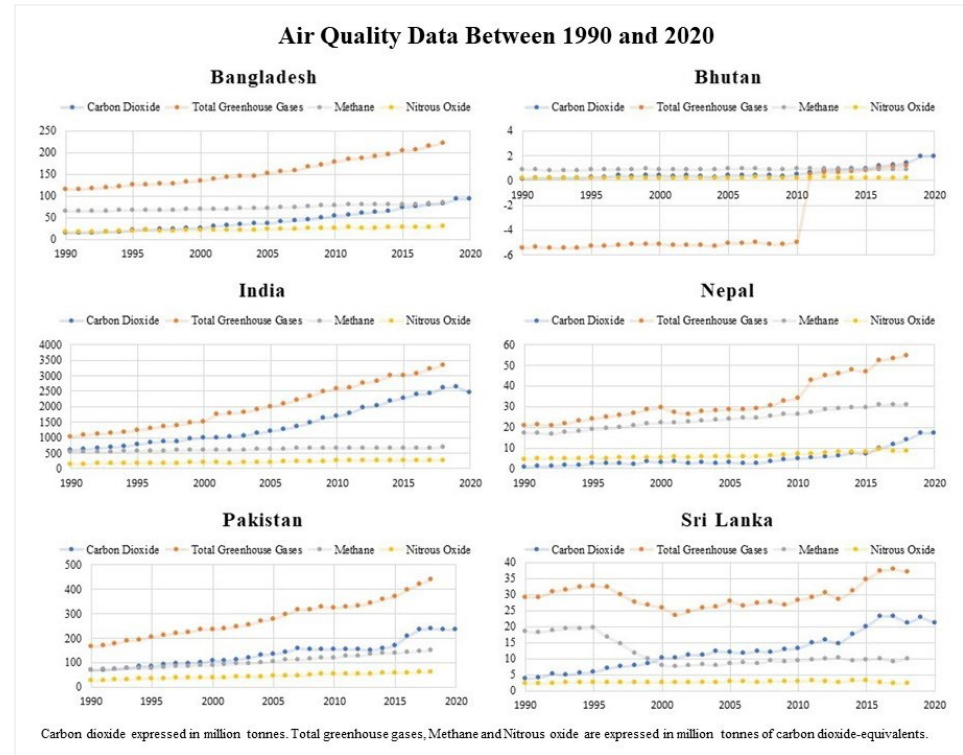
Figure 2. Air Quality Data Between 1990 and 2020 [15]. CO 2 is expressed in million tons. Total greenhouse gases, methane, and NO 2 are all expressed in million tons of carbon dioxide-equivalents.